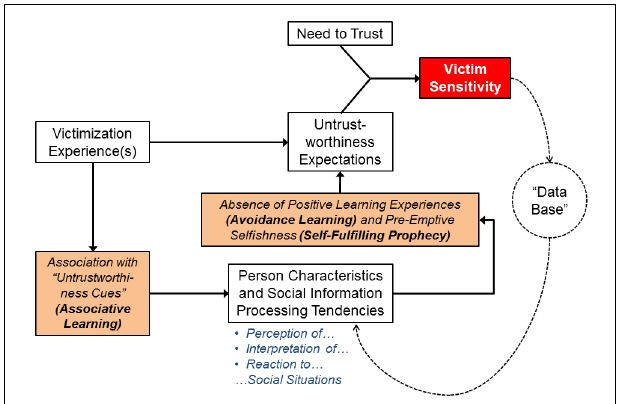
FIGURE 2 | Theoretical model explaining the “actual-genetic” stabilization of victim sensitivity across